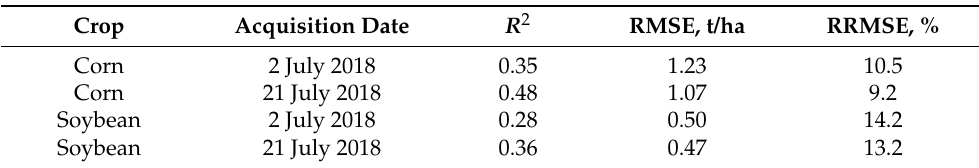
Table 2. Coefficient of determination R 2 obtained for the Coles fields for 2018 when using linear models between yields and surface reflectance (SR) values (all spectral bands) for the WV-3 images.